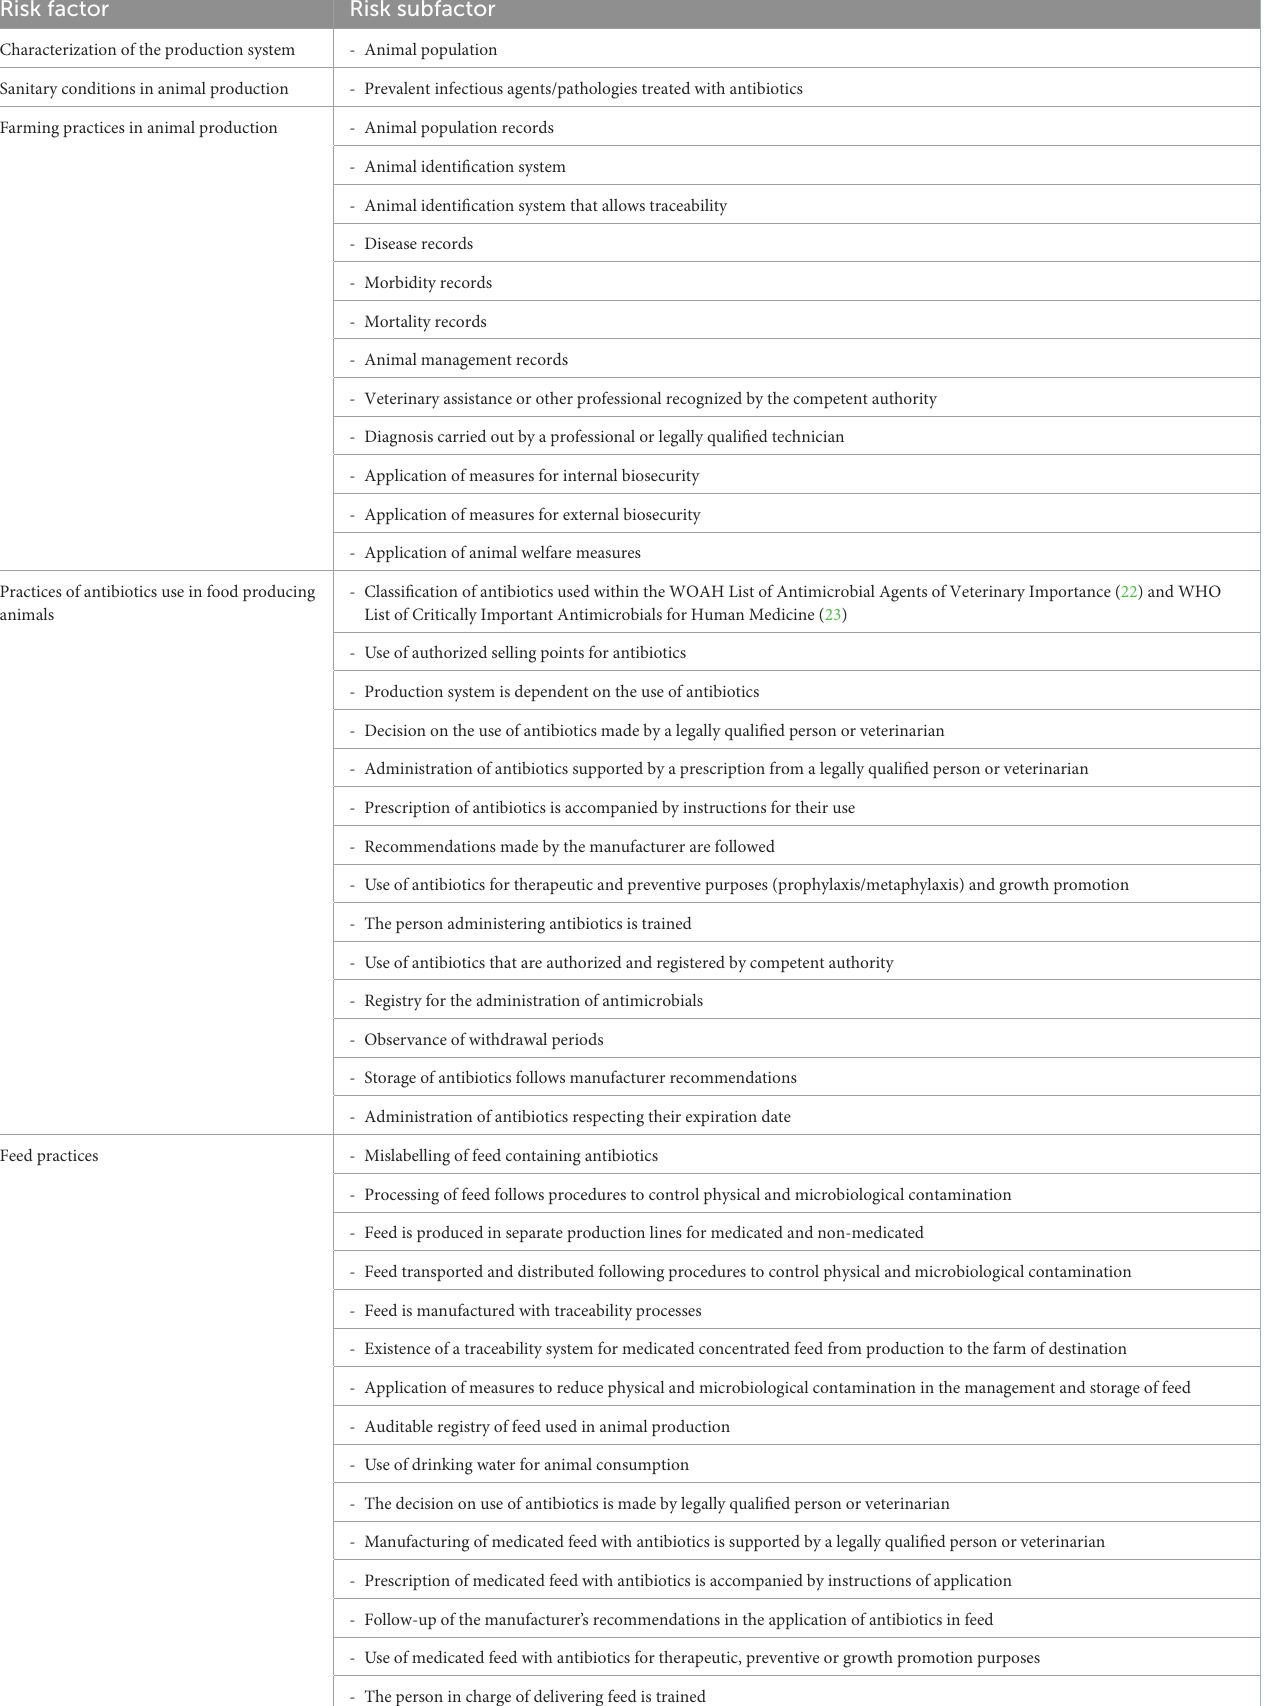
TABLE 1 AMR introduction risk factors and subfactors for animal and human